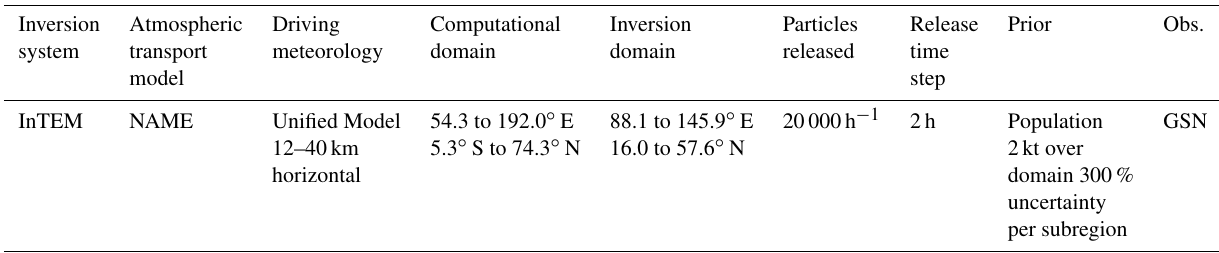
Table 2. The East Asian setup of the inversion system runs 2007–2018 in 2-year blocks: the meteorology, atmospheric transport model (ATM), and geographical domains over which the ATM is run; the number of particles released; the inversion time steps; prior information; and observations used.